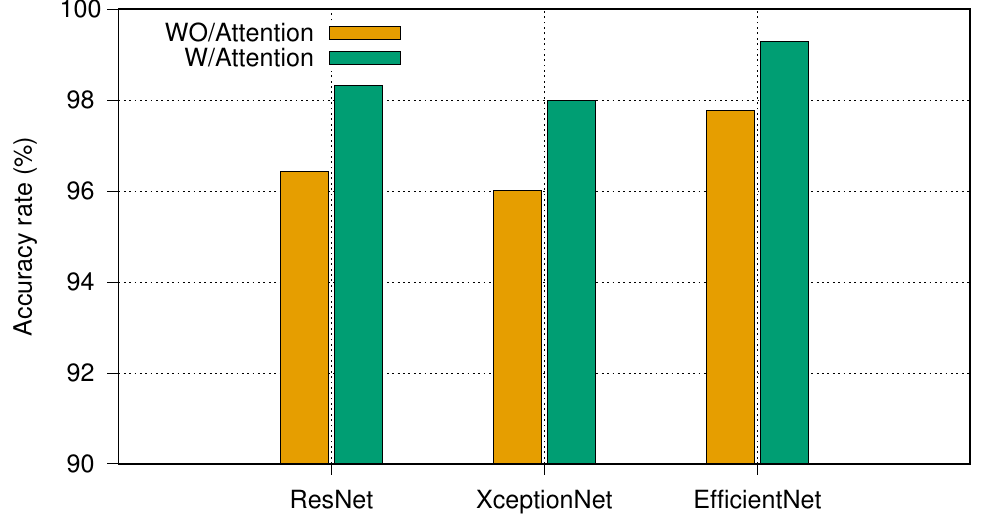
Figure 9. Performance of the presented attention-based white blood cell detection method compared with not using